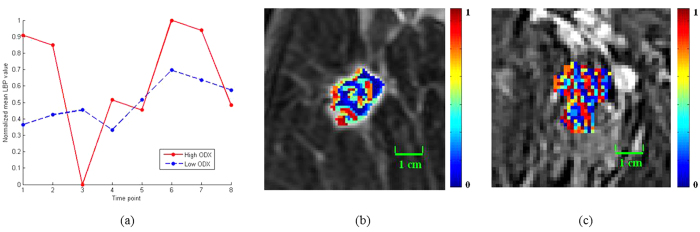
Comparison of contrast enhancement pattern and dynamic local binary pattern (DLBP) features (256 bins) of estrogen receptor (ER)-positive breast lesions between low OncotypeDX recurrence score (=11), low grade in 53-year-old woman and high OncotypeDX recurrence score (=41), high grade in 48-year-old woman.(a) Normalized mean DLBP values versus time points, and the color-coded DLBP image of (b) low OncotypeDX at peak enhancement (6th phase, 1.5T), and (c) high OncotypeDX at peak enhancement (6th phase, 1.5T). Note that the enhancement patterns vary widely in contrast uptake from time point to time point between two tumors.